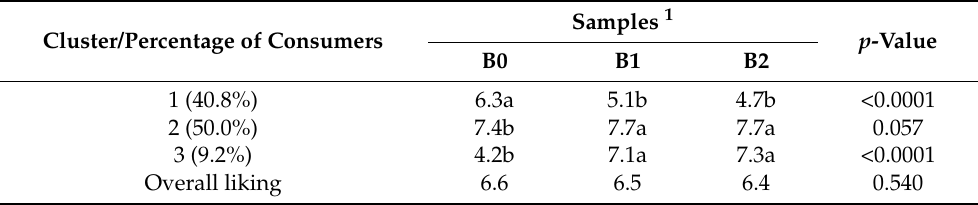
Table 6. Overall liking of the biscuit packages for the clusters of consumers obtained from agglomer- ative hierarchical